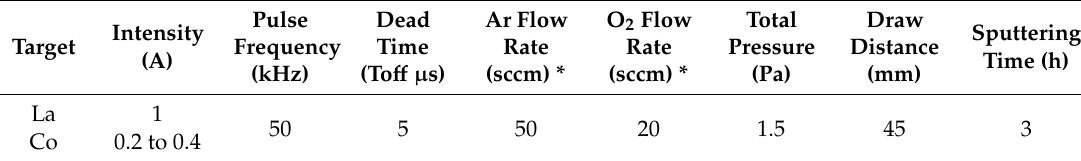
Table 1. Sputtering parameters used for LaCoO 3 coating.